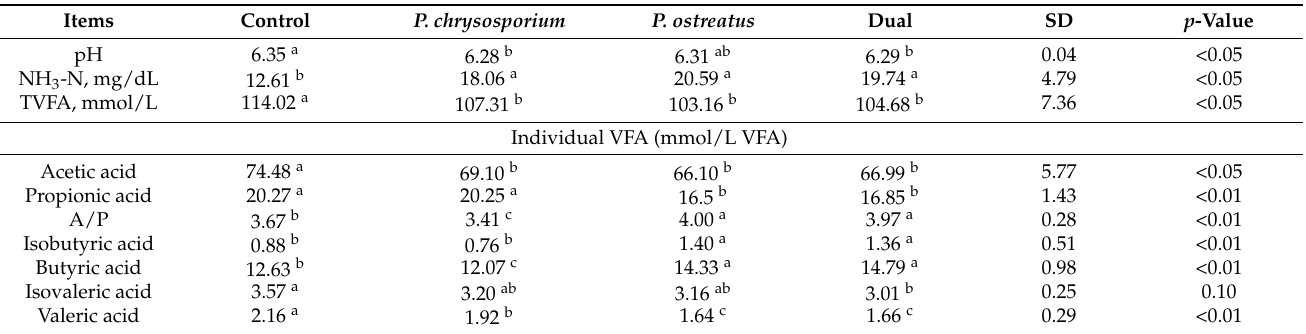
Table 4. Fermentation products of the control and the white tea residue with different treatments after 72 h of digestion by rumen microbiota in